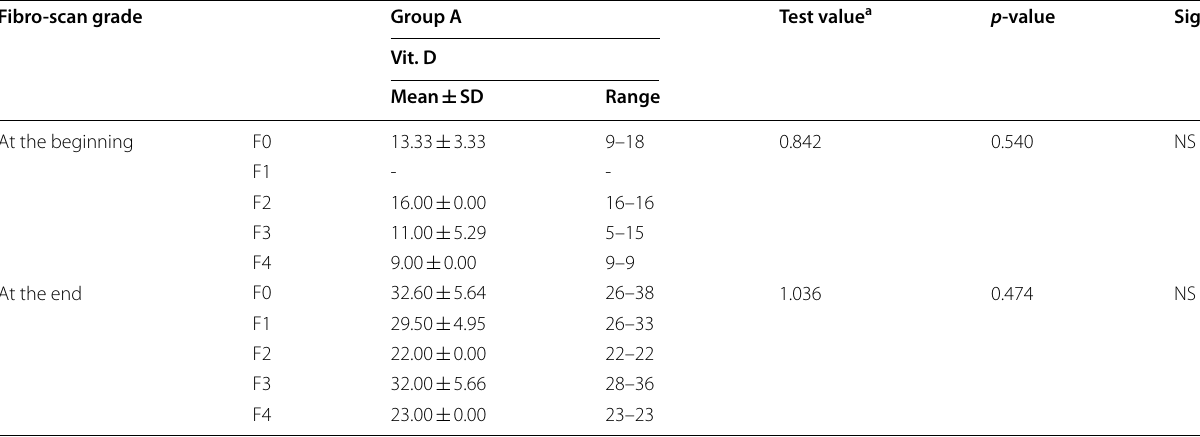
Table 10 Correlation between vitamin D levels with fibroscan grade at the beginning and at the end in group